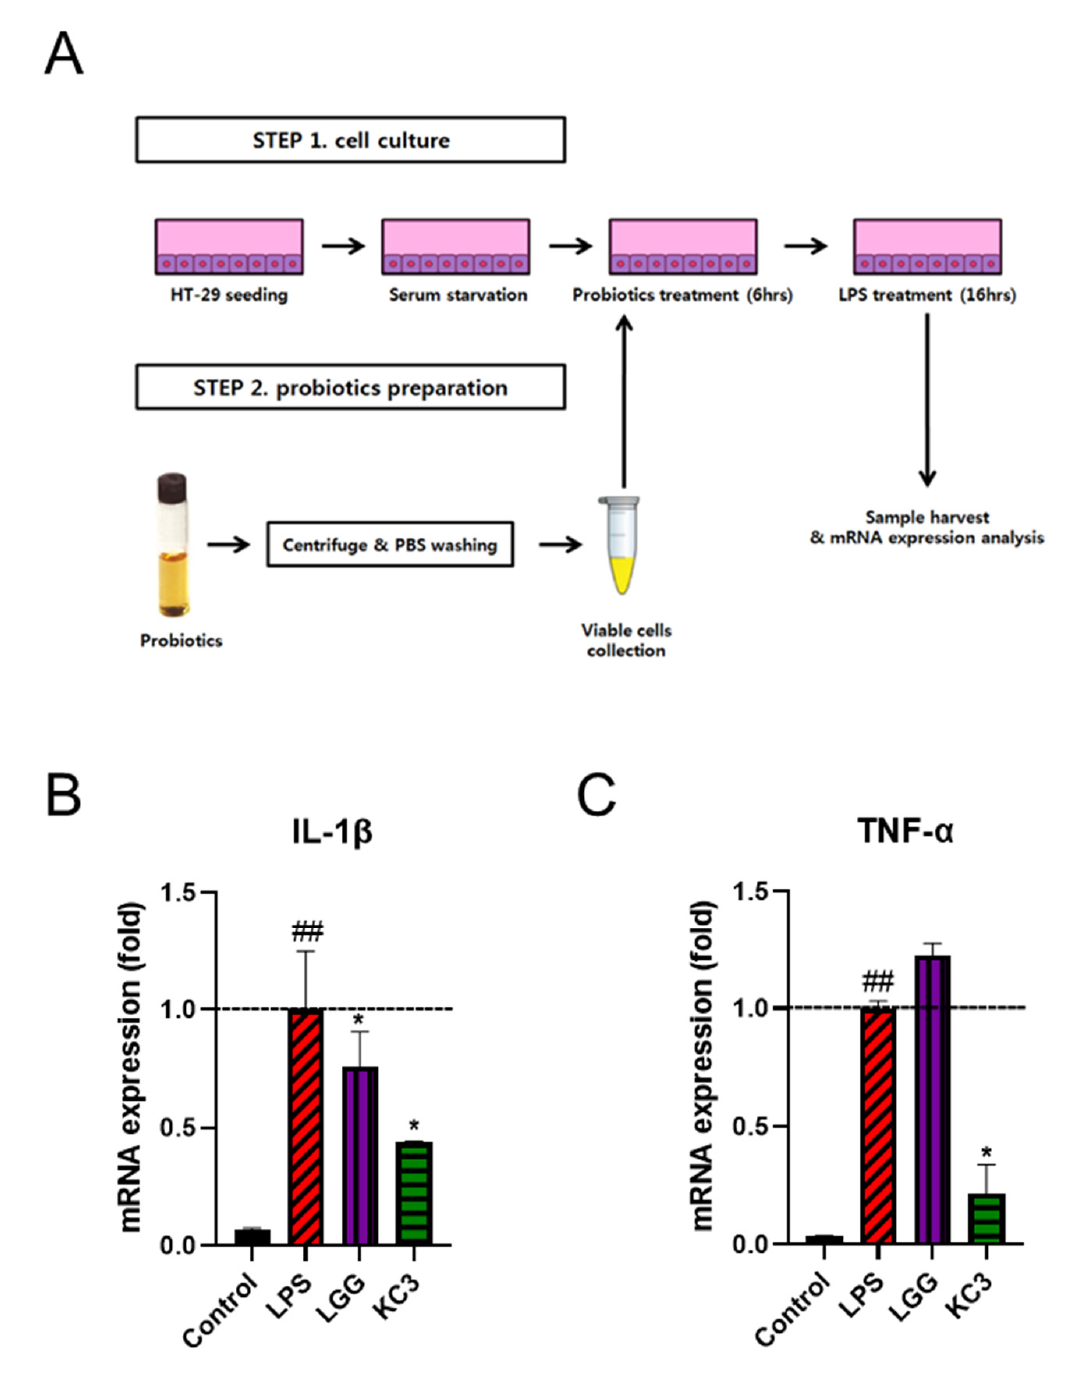
Figure 1. Anti-inflammatory effect of KC on LPS-induced inflammation. ( A ) Schematic of in vitro screening of lactic acid bacteria mRNA expression of pro-inflammatory cytokines of IL-1 β ( B ) and TNF- α ( C ) in LPS-treated HT-29 cells. * Significant difference compared with the LPS control group ( p < 0.05). ## Significant difference compared with the PBS control group ( p < 0.01).